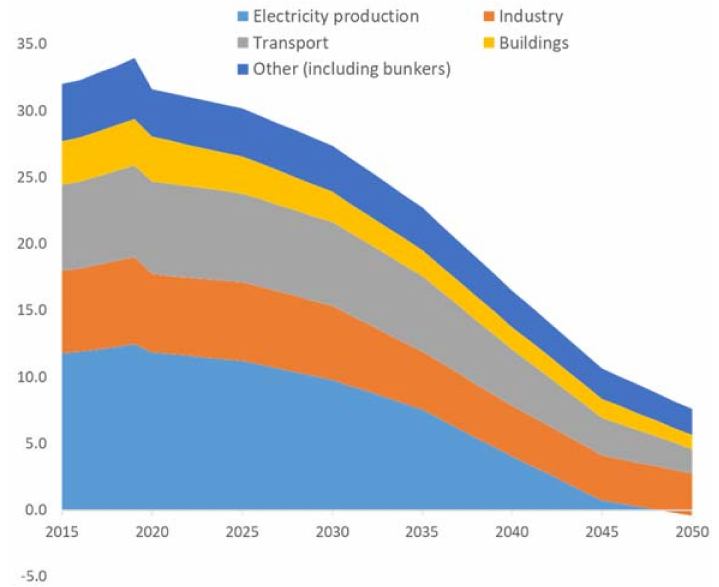
Figure 2. Global CO 2 emissions by sector in 2DEG-OPT scenario in the period 2015–2050 (in Gt CO 2 ).